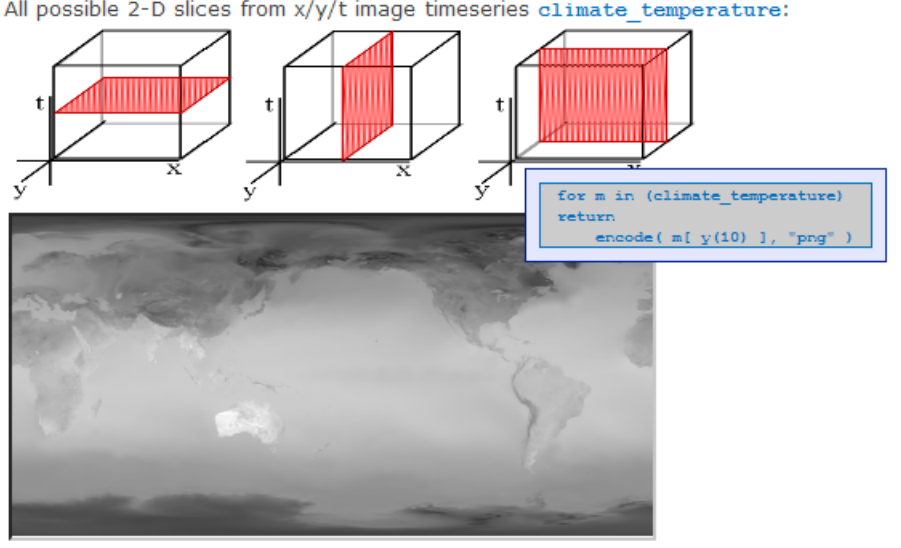
Figure 4. WCPS queries attached to pictograms for slicing of a 3-D cube in EarthLook.